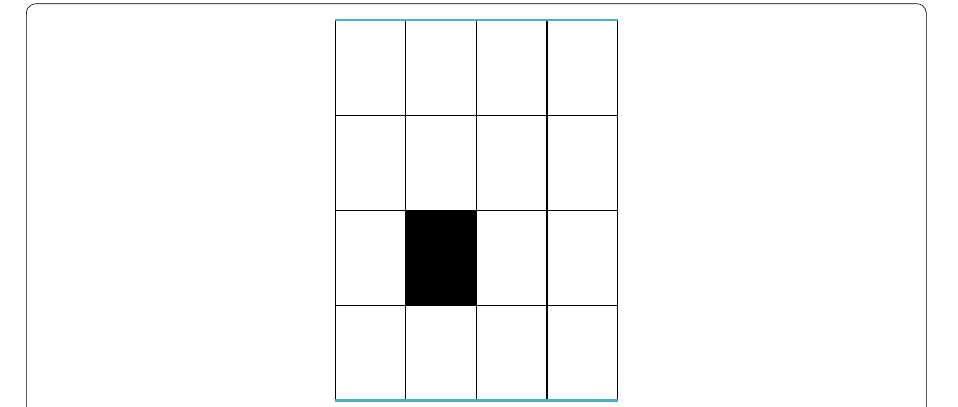
Fig. 1 An object (the black square) located in a phase